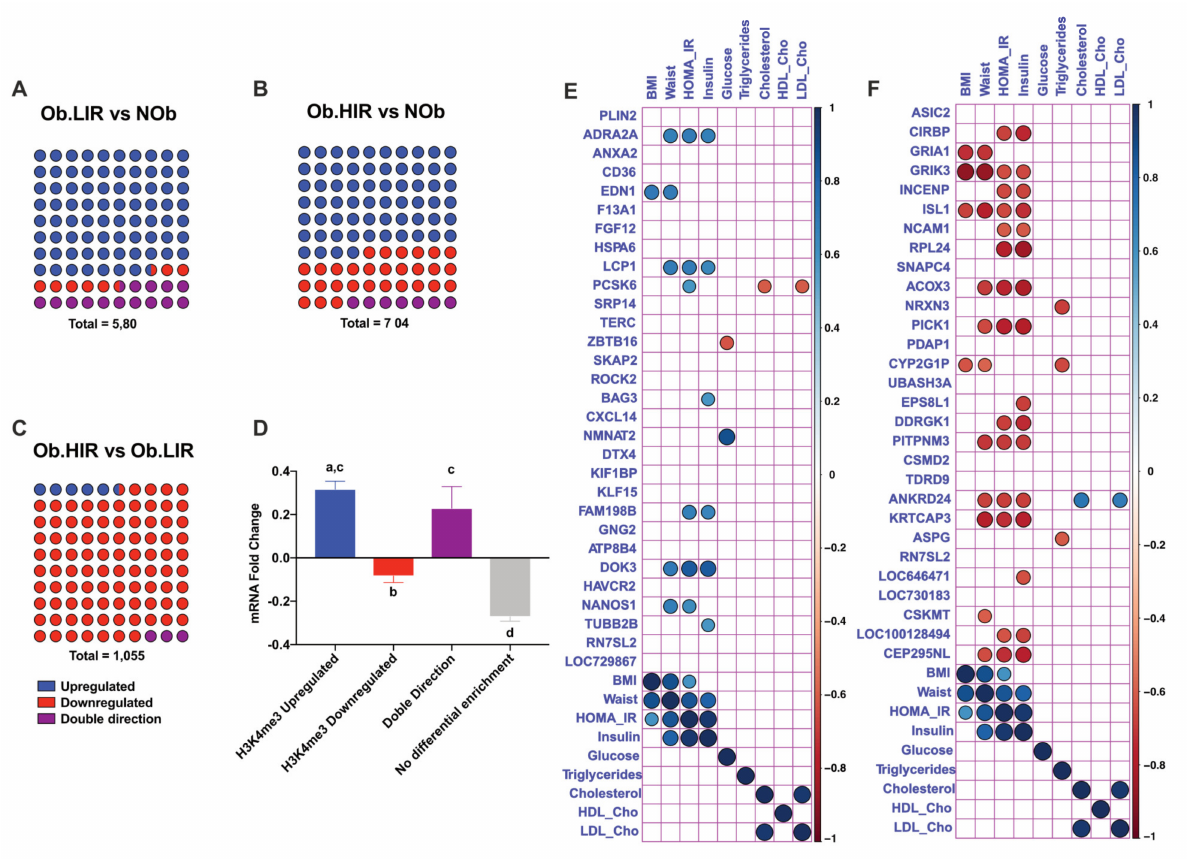
Figure 4. Percentage of genes upregulated, downregulated, with bidirectional enrichment of H3k4me3 and correlation between top 10 upregulated and downregulated genes. Genes, both with differential mRNA and H3k4me3 enrichment were subtracted, and the direction of the enrichment was calculated for the different comparisons between groups: Ob.LIR vs. NOb ( A ), Ob.HIR vs. NOb ( B ) and Ob.HIR vs. Ob.LIR ( C ). Mean Fold-change (FC) mRNA for the different genes according to H3K4me3 enrichment direction, and the subset of genes in which differential H3k4me3 enrichment was not present ( D ). Correlations between upregulated and downregulated genes and clinical variables ( E , F ). H3K4me3 enrichment direction is shown by color blue for genes enriched; red for genes decreased; and blue for genes with both, enriched and decreased peaks. In the correlation analysis, colored genes mean p < 0.05 according to Spearman correlation. Blue dots mean positive correlations, while red dots mean negative